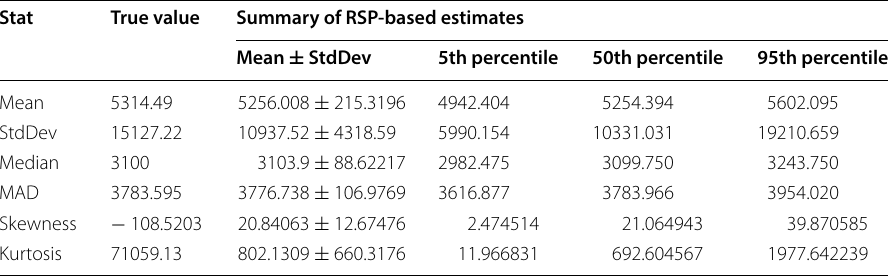
RSP-based estimates were calculated from a sample of RSP blocks ( g = 100